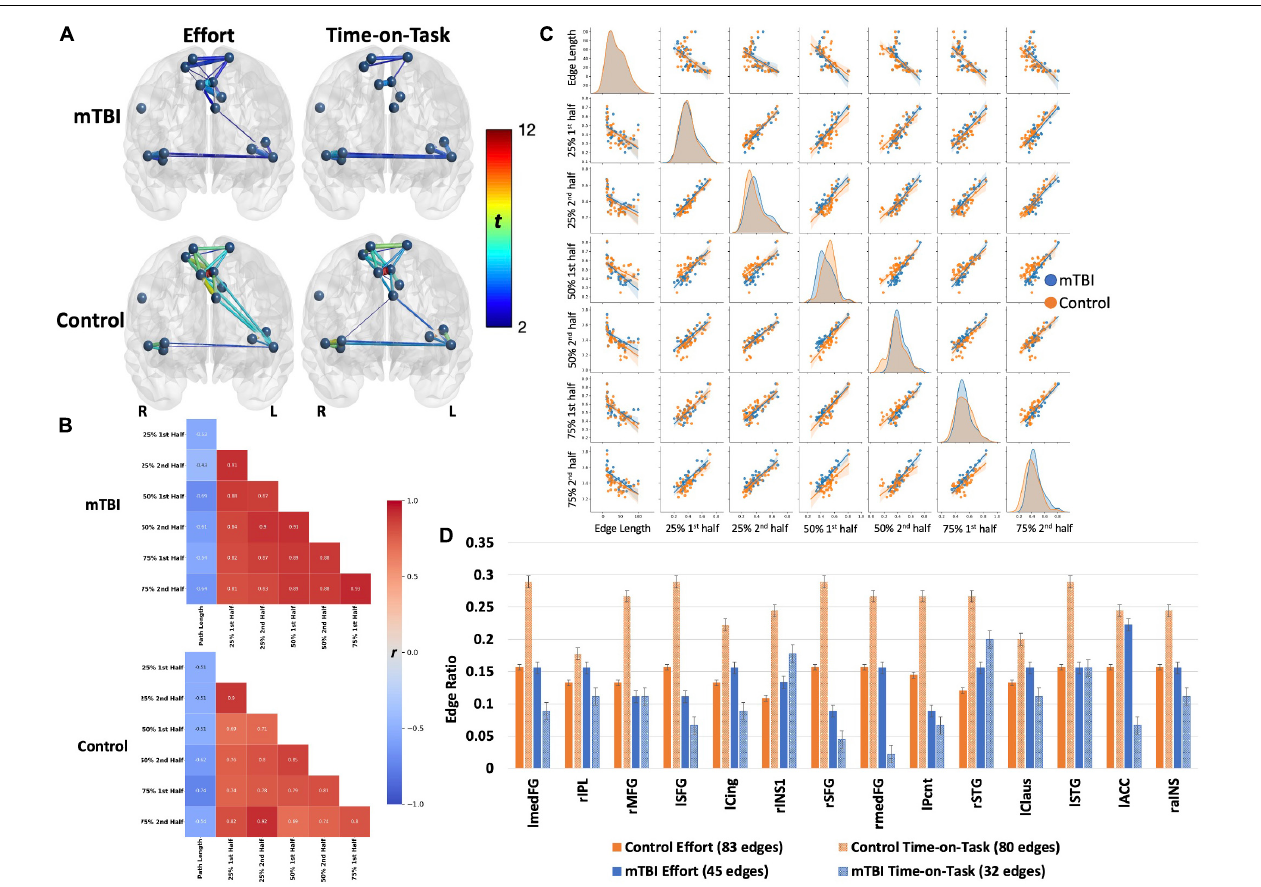
FIGURE 4 | Both groups demonstrated robust main effects for effort level and TOT with similar spatial distributions across effects (effort or TOT) and across groups (A) . However, the effects were stronger in the control group ( t -values presented by the color spectrum and edge thickness). For both groups, the edge with strongest effects (for effort and TOT) was the left medial frontal gyrus–right medial frontal gyrus [mTBI effort effect: t (63) = 5.24, control effort effect: t (40) = 11.81; mTBI TOT effect: t (63) = 4.61, control TOT effect: t (40) = 11.4, all p s < 0.001]. Connectivity between the left insular and medial frontal nodes was stronger for the effort effect in both groups, but only one edge connecting these brain regions was significant in the mTBI group (left precentral gyrus-left claustrum). Connections between medial frontal and insular or temporal nodes were absent in TOT for the mTBI group. The (B) heatmaps and (C) pairplots present correlation strengths and distributions ( C , center diagonal) for the edges that were significant for effort level and TOT effects by group. The heatmaps show that for the controls ( B , bottom), connectivity was strongest at the beginning of the task (25% effort level), indicated by darker red only in the top left corner, while connectivity was strong throughout the task in the mTBI group ( B , top). The pairplots demonstrate that the FC over the course of the task was similar by group but more kurtotic in the OC group early in the task (at 25% second and 50% first). FC was more kurtotic at the end of the task for the mTBI group. The heatmaps and pairplots also present the negative relationship between edge length and FC in both groups, which was strongest at the 50 and 75% effort levels in the mTBI group, but more so for the 75% effort level in the OC group. The latter may indicate a “preference” for shorter Euclidean distances when a task becomes more effortful. (D) Node degree was presented as the number of connections each node was engaged in, standardized for the total number of significant edges in each effect (edge ratio), with more nodes engaged for the effect of effort level in the controls, but more nodes engaged in the TOT effect for the mTBI group. Error bars, standard error. lmedFG, left medial frontal gyrus; rIPL, right inferior parietal lobule; rMFG, right middle frontal gyrus; lSFG, left superior frontal gyrus; lCing, left mid cingulate cortex; rINS1, right insula 1; rSFG, right superior frontal gyrus; rmedFG, right medial frontal gyrus; lPcnt, left precentral gyrus; rSTG, right superior temporal gyrus; lClaus, left claustrum; lSTG, left superior temporal gyrus; lACC, left anterior cingulate cortex; and raINS, right anterior